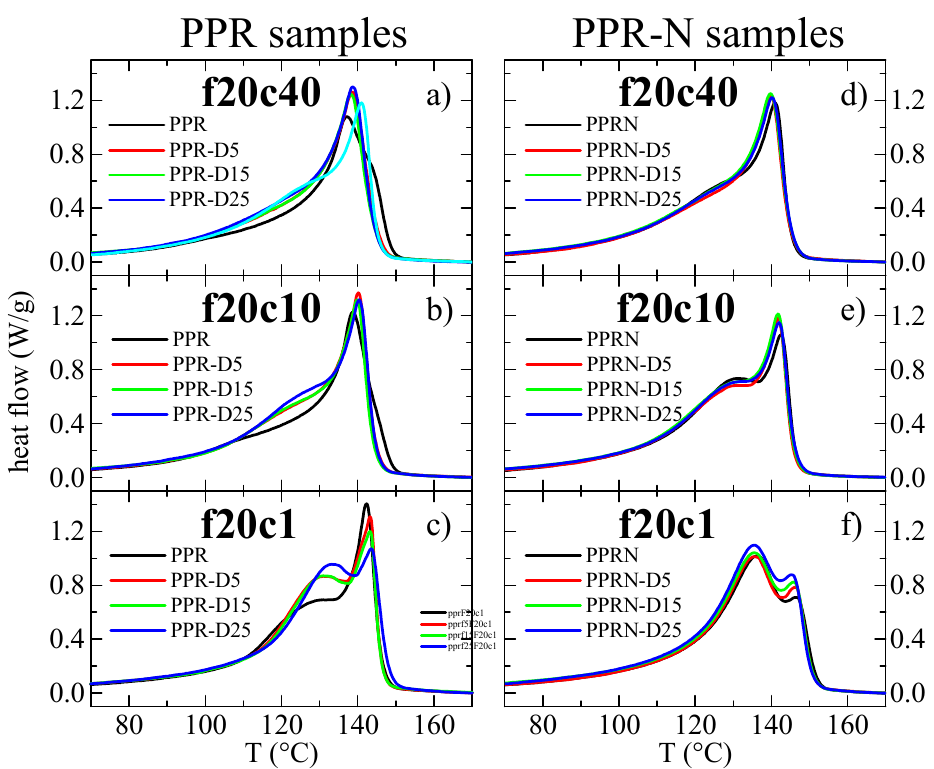
Figure 8. Variations with the DSF content in the differences between the peak crystallization tem- perature of a certain sample and that of the PPR specimen for the cooling rate of 10 °C/min.